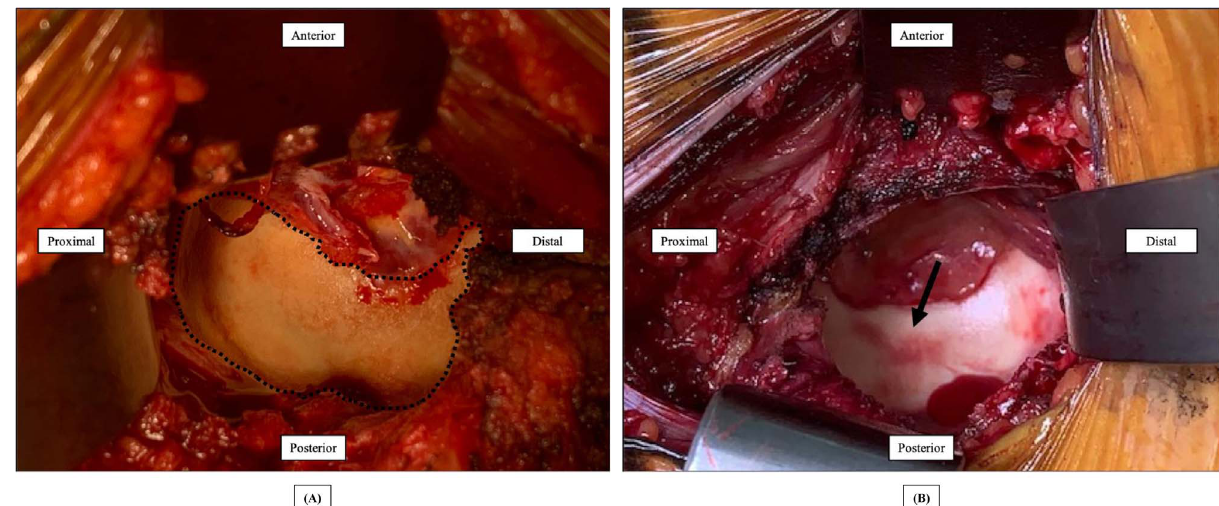
Figure 1. (A) Overall degeneration in the acetabular cartilage (demarcated by the dotted line). (B) Partial damage in the acetabular cartilage (black arrow). Both macroscopic views of the acetabulum show the right hip via the direct anterior